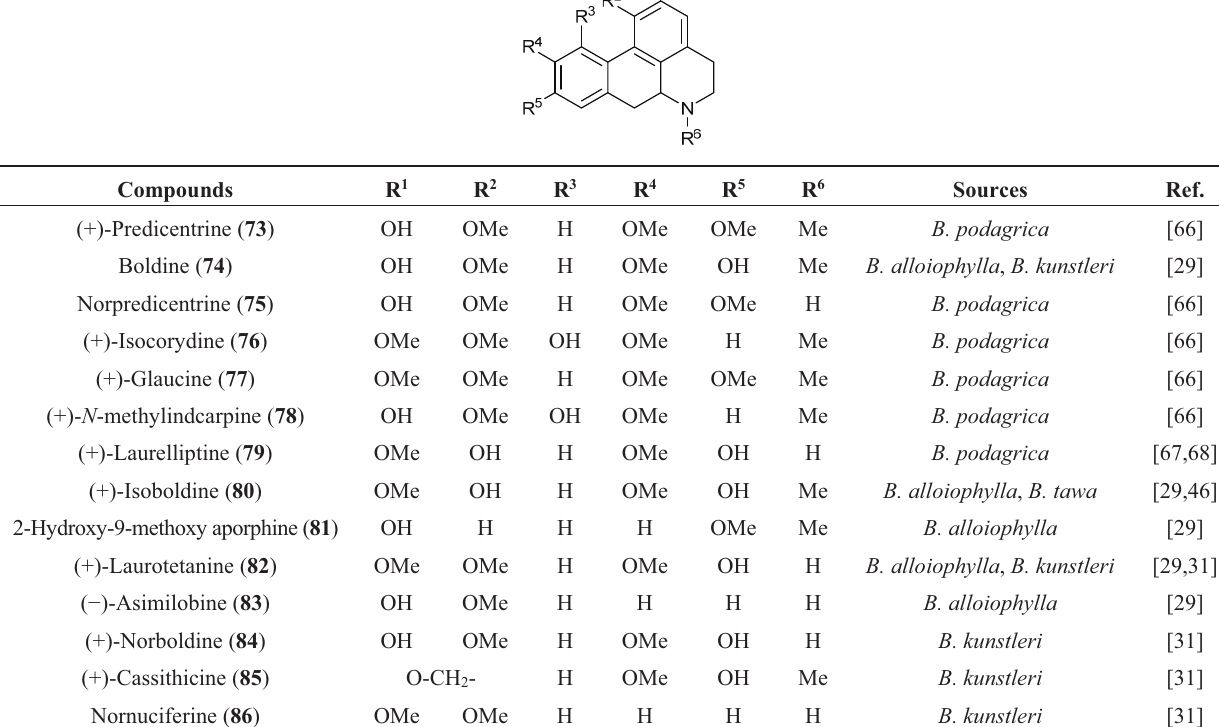
Table 3. Substitution pattern of aporphine alkaloids